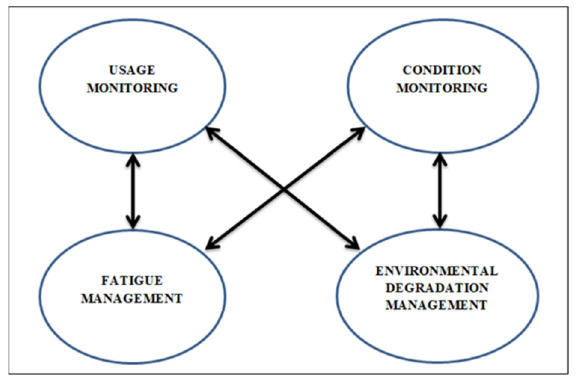
Figure 1. ASIP methodology.